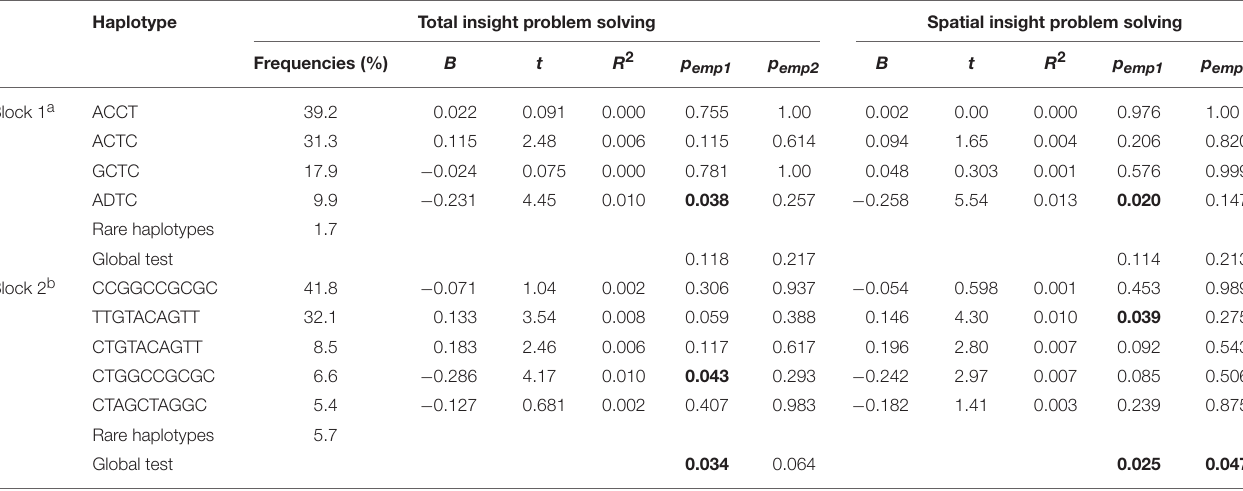
TABLE 3 | Associations of haplotypes with total and spatial insight problem solving.